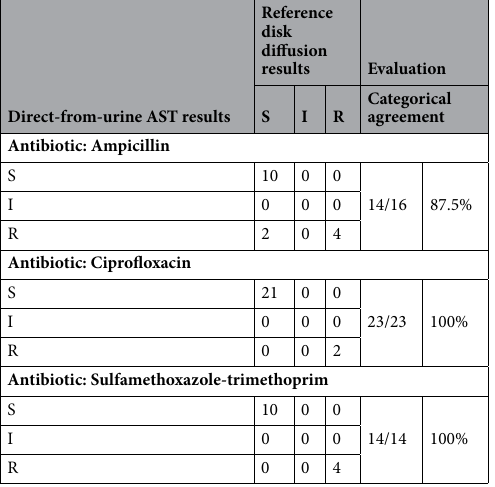
Table 1. Direct-from-specimen AST clinical feasibility study – 1×/0.002× configuration. The categorical agreement for ampicillin is calculated not including the unauthenticated results for UGF039_1 and